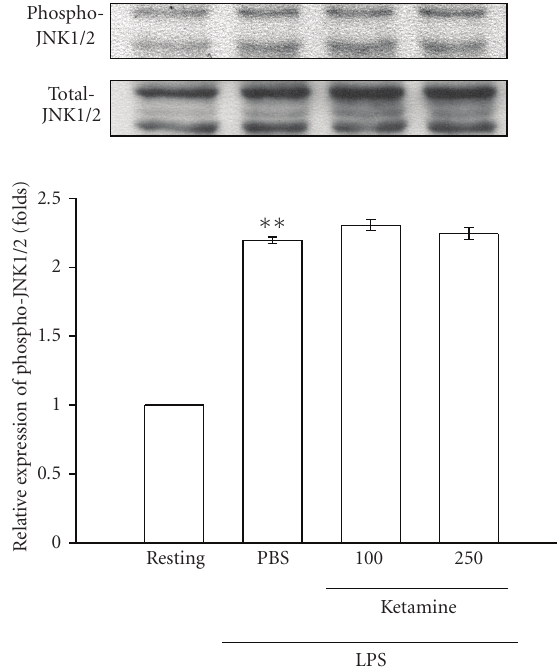
Figure 6: E ff ect of ketamine on JNK1/2 phosphorylation in lipopolysaccharide (LPS)-activated microglia. Microglia (5 × 10 5 cells mL − 1 ) were treated with ketamine (100 and 250 μ M) or an isovolumetric PBS bu ff er for 30 minutes, followed by the addition of LPS (100ngmL − 1 ) for 45 minutes. JNK1/2 phosphorylation was determined by Western blotting with a monoclonal antibody which recognizes only phosphorylated JNK1/2 (p46/p54). Data are presented as the means ± S.E.M. ( n = 3). ∗∗ P < . 01, compared